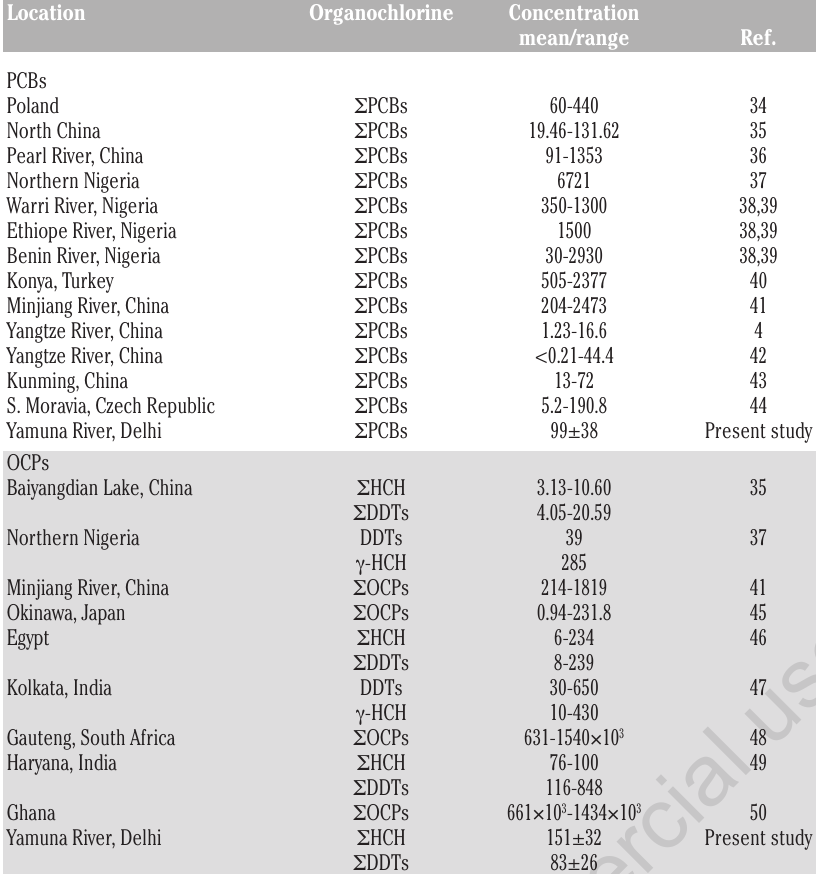
Table 6. Global comparison of concentration of organochlorines in surface water (ng/L).